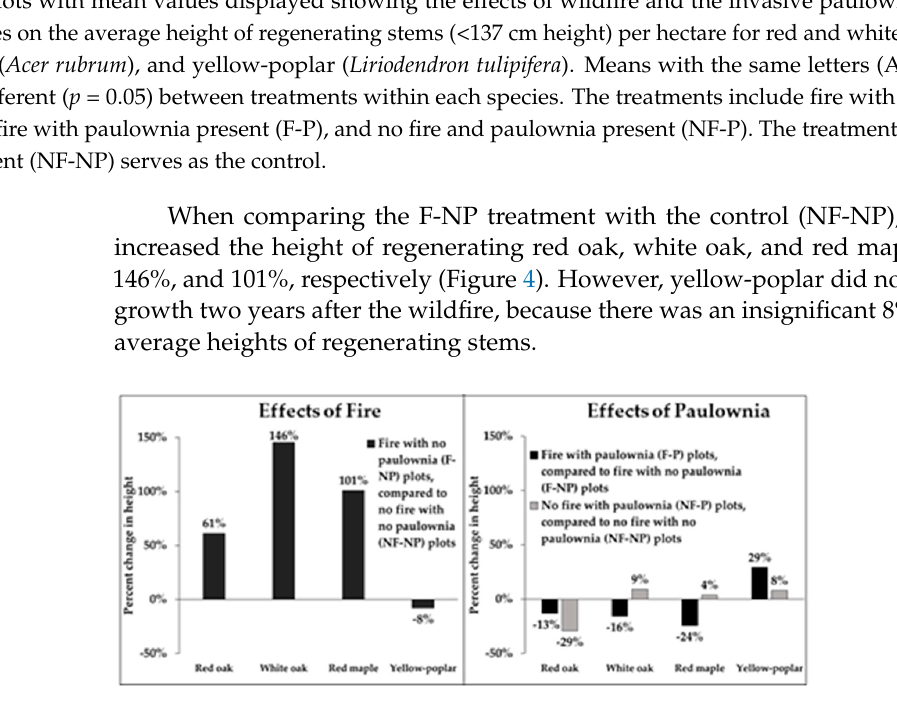
Figure 4. The effects of fire and the presence of paulownia ( Paulownia tomentosa ) two years after wildfire on the percent change in the average height of regenerating stems (<137 cm height) of red and white oaks ( Quercus sp.), red maple ( Acer rubrum ), and yellow-poplar ( Liriodendron tulipifera